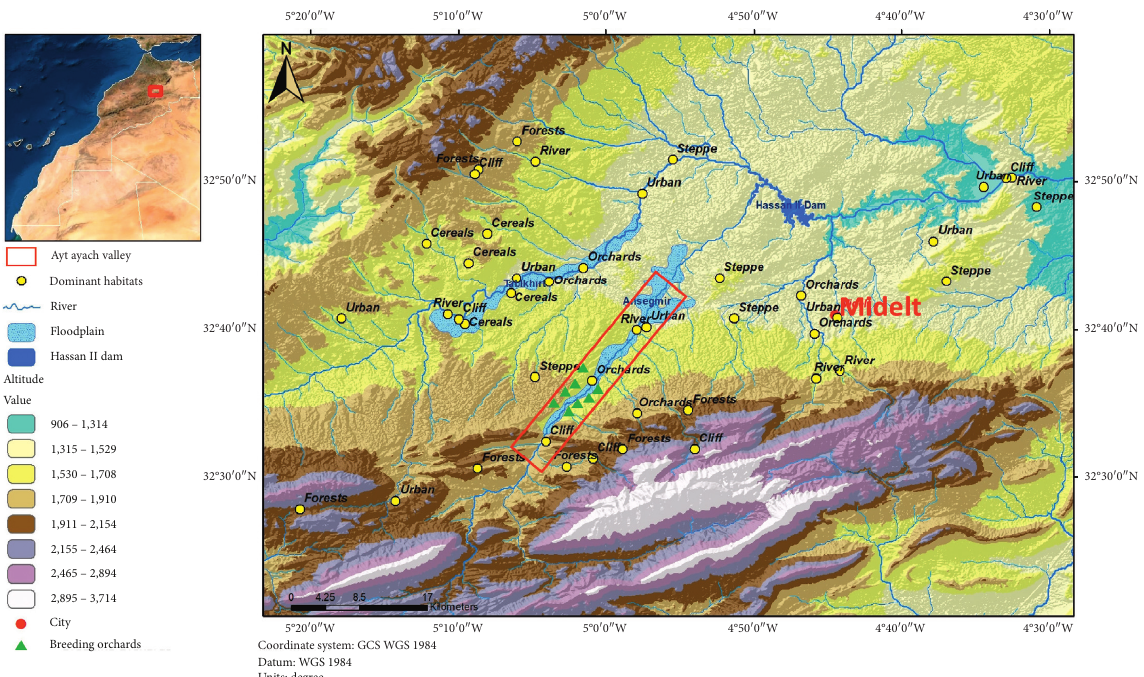
Figure 1: Location of the studied habitats at Ait Ayach zone during 2016 season.